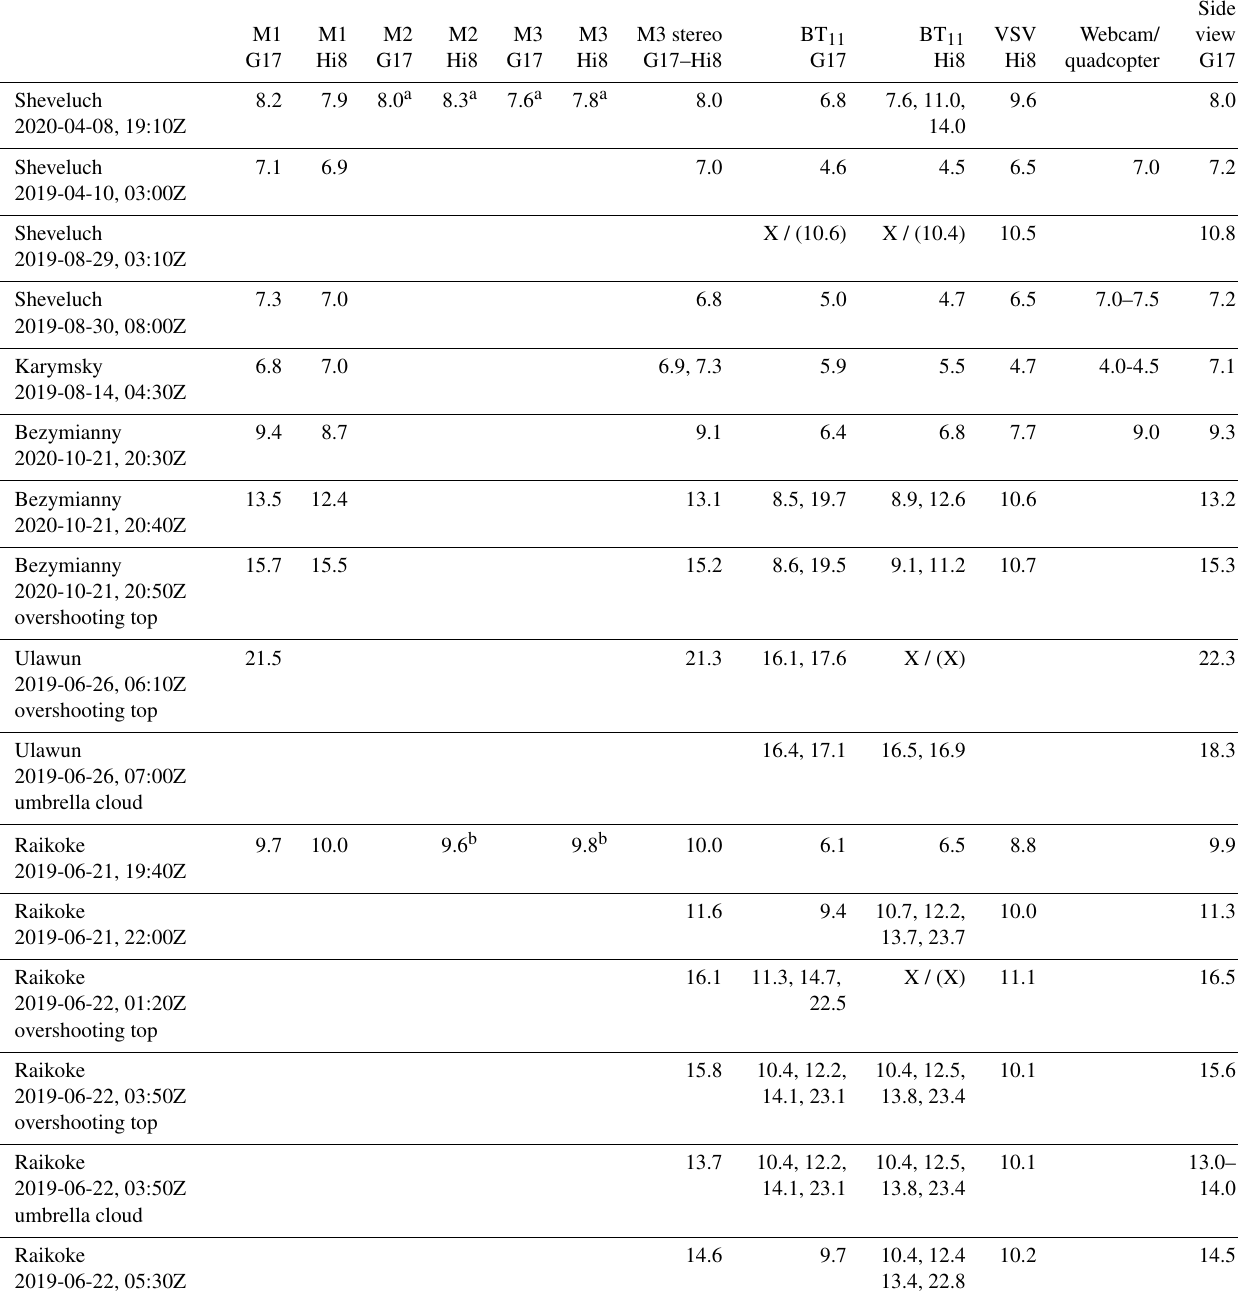
Table 1. Case study plume height estimates, in kilometer and rounded to the nearest hectometer, derived from GOES-17 (G17) and Himawari- 8 (Hi8) satellite data or webcam/quadcopter footage. The retrieval methods are described in Part 1. The three traditional geometric methods are as follows. Method 1 (M1): sensor-projected length, method 2 (M2): true (stick) shadow length, and method 3 (M3): edge shadow length; method 3 can also be applied in “stereo mode” using the parallax between the GOES-17 and Himawari-8 image locations of a given plume feature. Height is also estimated by matching the minimum 11µm brightness temperature (BT 11 ) to the ERA5 temperature profile; if the reanalysis profile yields no solution due to plume undercooling (X), the height derived from the U.S. Standard Atmosphere 1976 temperature profile is given instead in parenthesis. VolSatView (VSV) is the temperature method used by KVERT. The last column is the new geometric side view estimate, obtained from GOES-17 fixed grid